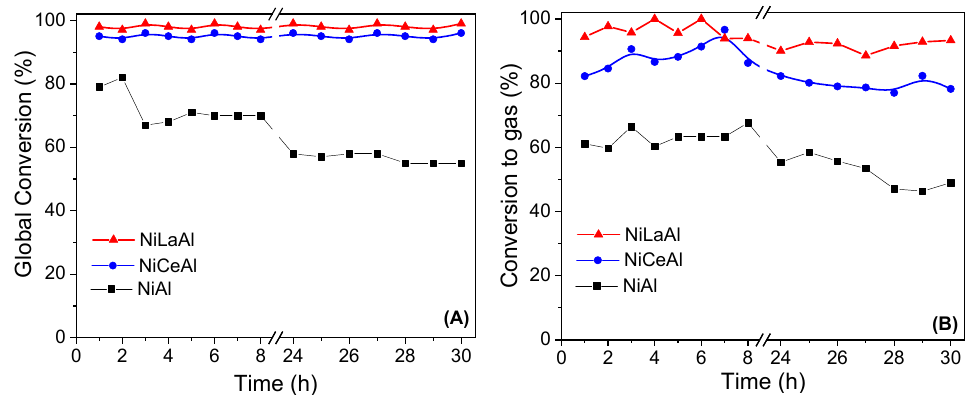
Figure 5. Butanol global conversion ( A ) and conversion to gas ( B ) versus time on stream.